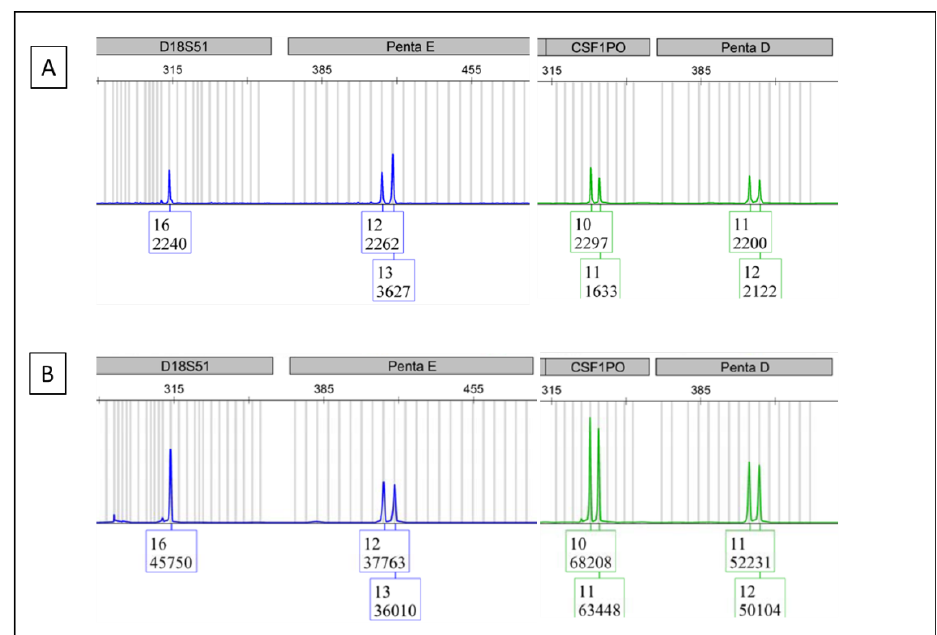
Figure 3. This figure consists of the electropherograms from multiple samples of the same category to protect the DNA fingerprint of any one sample. ( A ) is the DNA fingerprint from a common reagent. ( B ) is the DNA fingerprint from the BCR/ABL1 real-time PCR reaction mixture with a high BCR/ABL1 level.